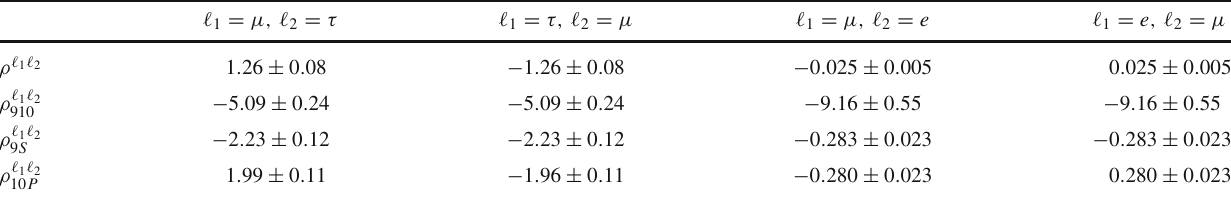
Table 2 Coefficients for the numerator of A (cid:3) 1 (cid:3) 2 width in Eq. (16)